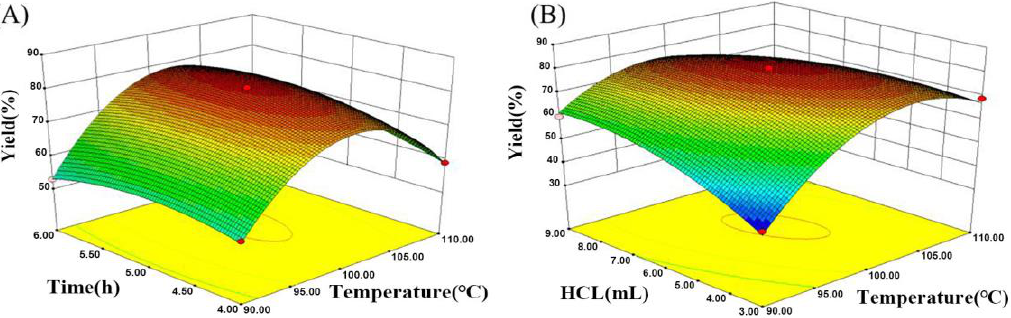
Figure 5. ( A ) Response surface for yield versus temperature and time; ( B ) response surface for yield versus temperature and dose of hydrochloric acid.